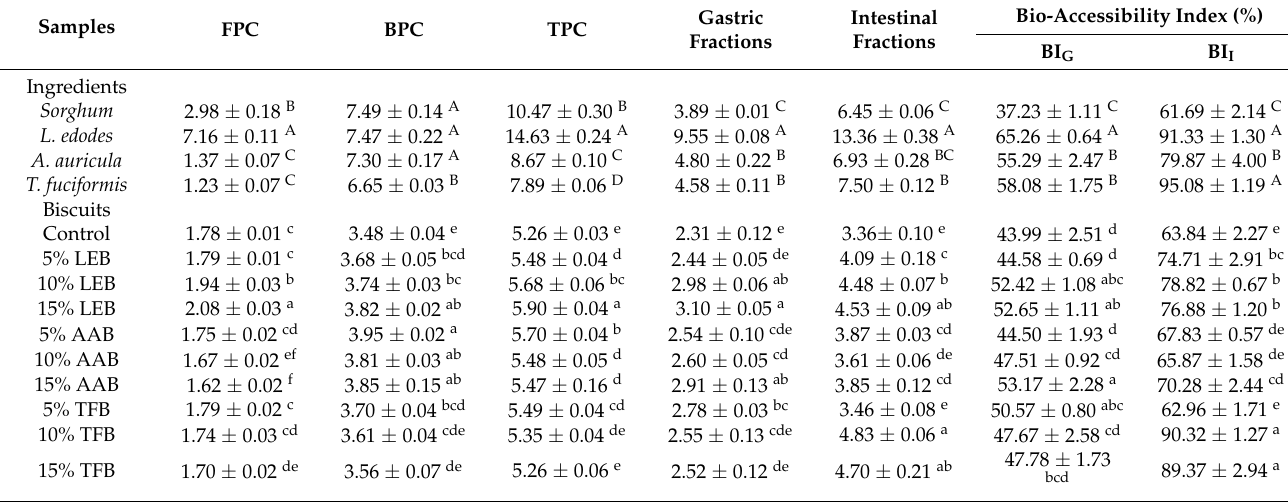
Values = means ± standard deviation ( n = 3). FPC—free phenolic content (methanol extraction); BPC—bound phenolic content (alkaline hydrolysis); TPC—total phenolic content; TPC = FPC + BPC. Values in the same column for ingredients with different uppercase letters are significantly different ( p < 0.05). Values in the same column for biscuits with different lowercase letters are significantly different ( p < 0.05). Abbreviations: LEB- L. edodes biscuit; AAB— A. auricula biscuit; TFB— T. fuciformis biscuit; BI (bio-accessibility index) = phenolic content of gastric (or intestinal) supernatant/total phenolic content of